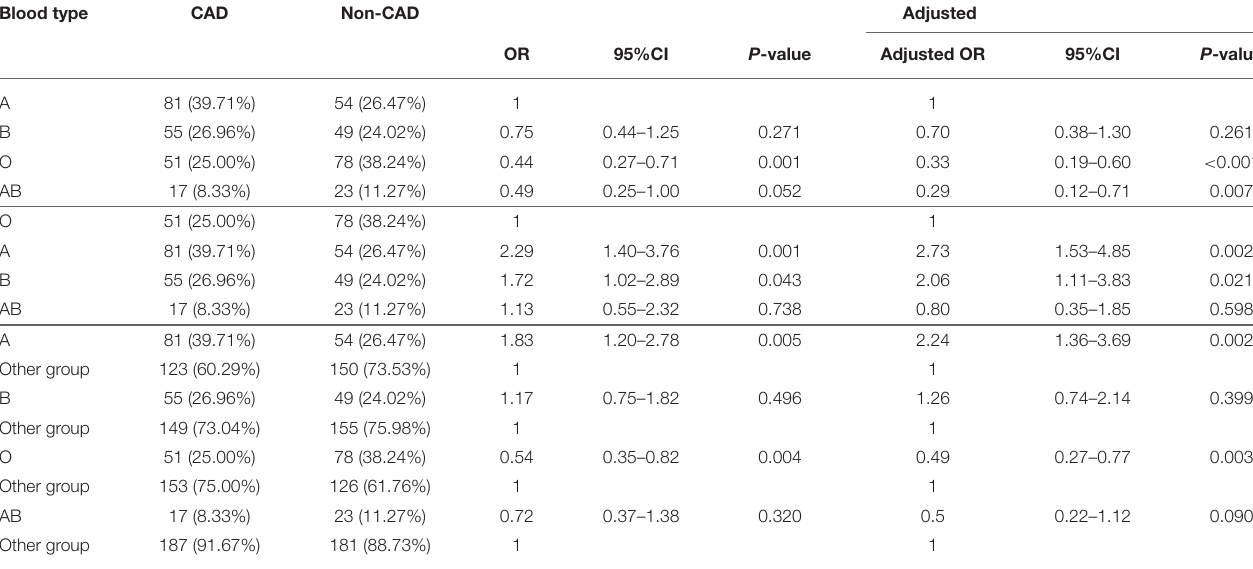
TABLE 2 | Comparison of ABO blood group between ESRD patients with or without CAD. Blood type